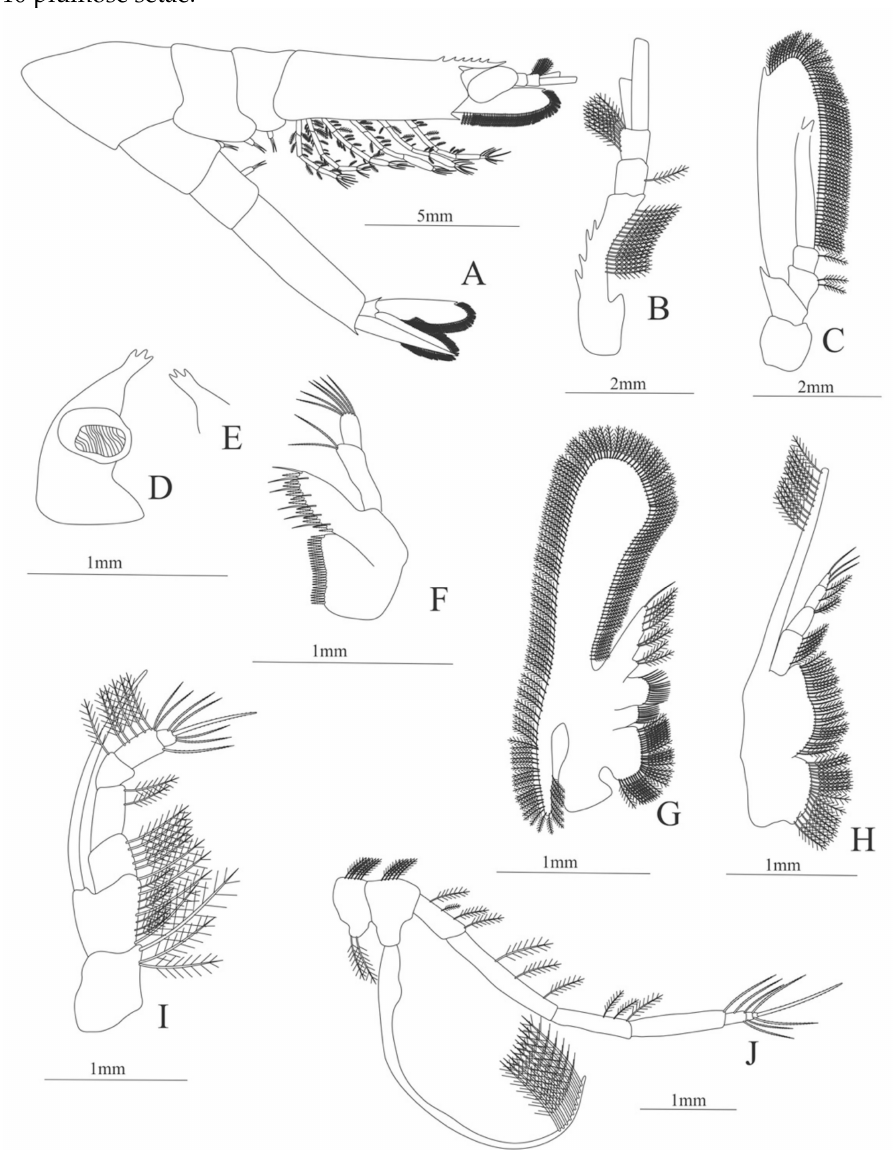
Figure 12. Nematocarcinus cursor : ( A ) lateral view; ( B ) antennule; ( C ) antenna; ( D ) left mandible; ( E ) right mandible (cutting edge); ( F) maxillule; ( G ) maxilla; ( H ) first maxilliped; ( I) second maxilliped; ( J ) third